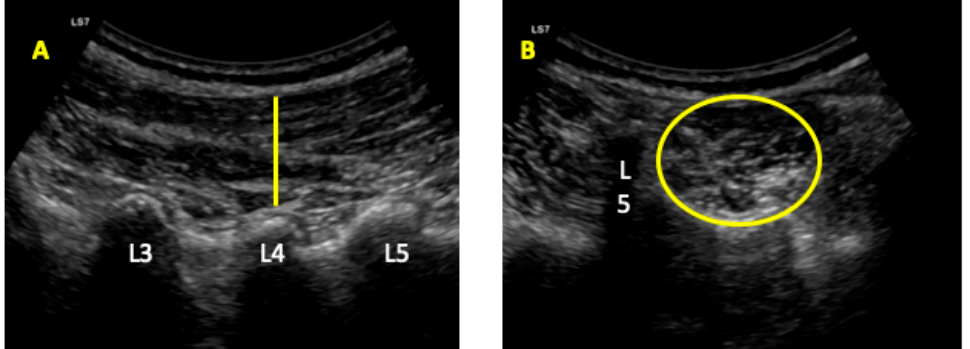
Figure 2. Ultrasound imaging for the multifidus thickness ( A ) and cross-sectional area (CSA) ( B ).